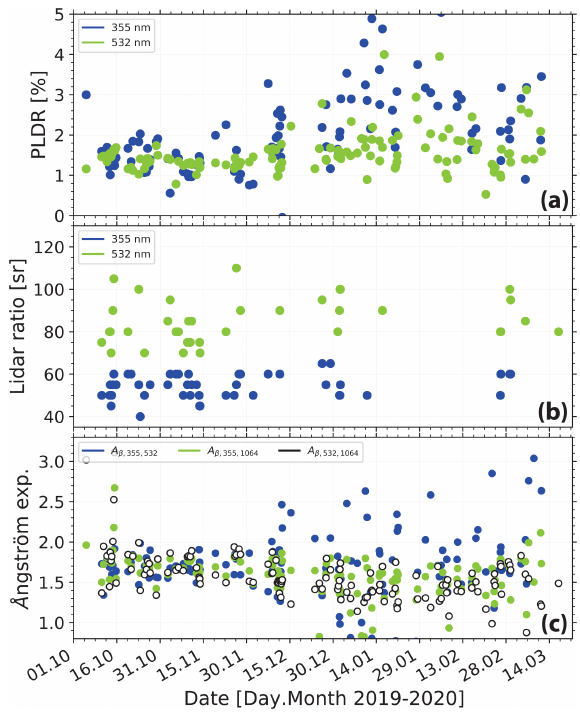
Figure 15. (a) Overview of smoke optical properties in terms of (a) particle linear depolarization ratio (PLDR), (b) extinction-to- backscatter ratio (lidar ratio), and (c) backscatter-related Ångström exponent. All results are derived from Polly observations within the smoke layer. The considered time period spans from 1 October 2019 to 22 March 2020. The scatter in the data is caused by signal noise and atmospheric variability and also weakly by a residual effect af- ter PSC impact correction (depolarization ratio and Ångström ex- ponent; January to March 2020).